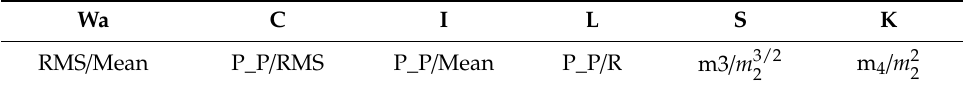
Table 3. The general dimensionless statistics used for sample construction.